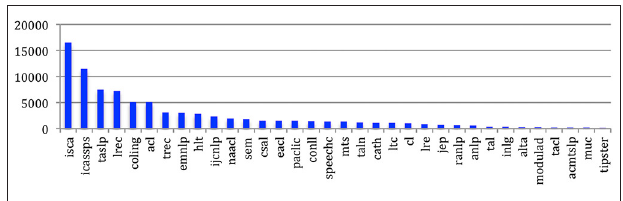
FIGURE 12 | Number of different authors having published at each source.